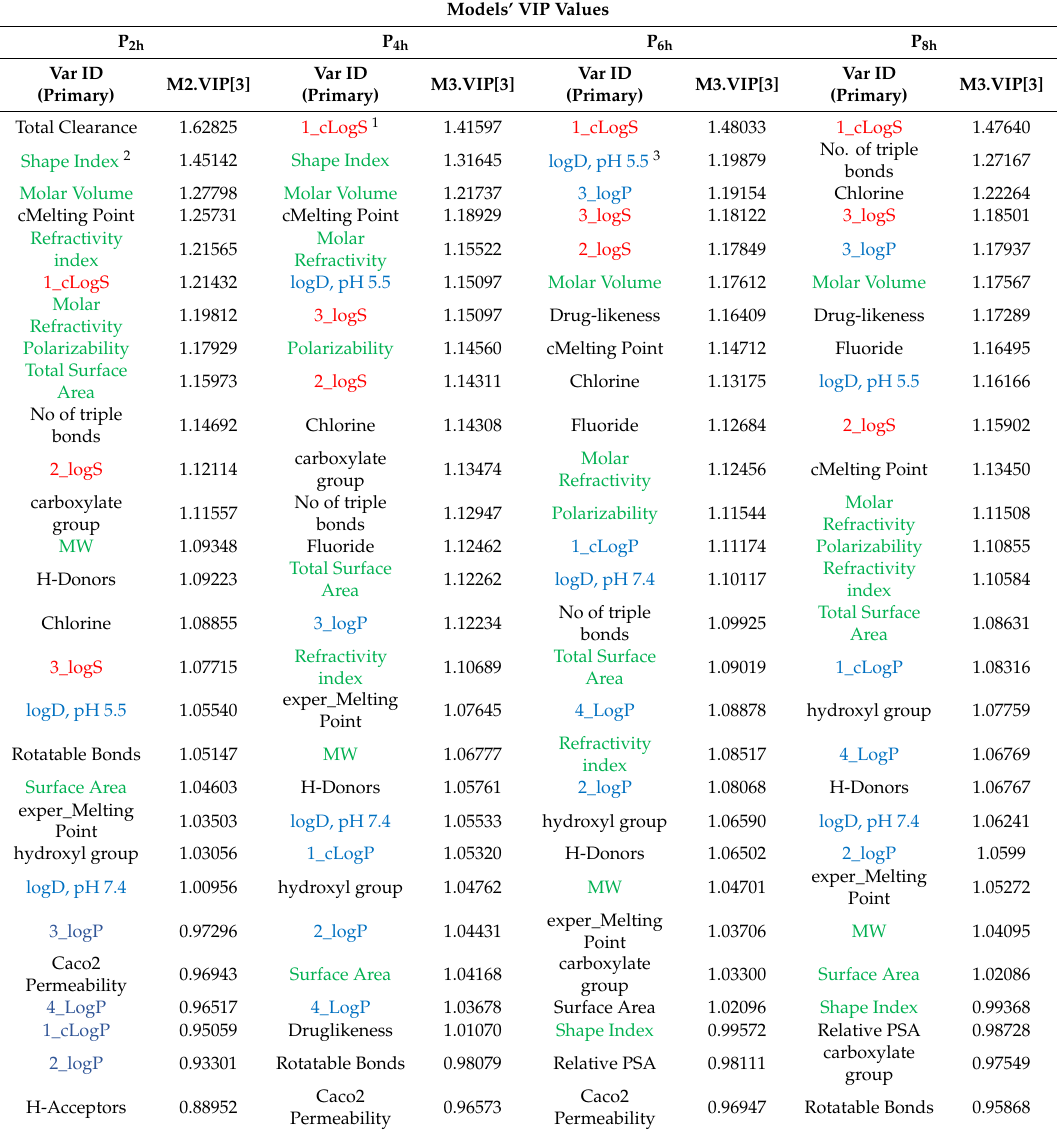
1 red indicates positive contribution, 2 green indicates size related descriptors, 3 blue indicates negative